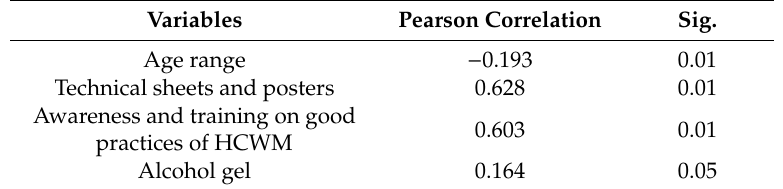
Table 7. Factors related to the sta ff belief that the department has a strategy of waste management. Variables